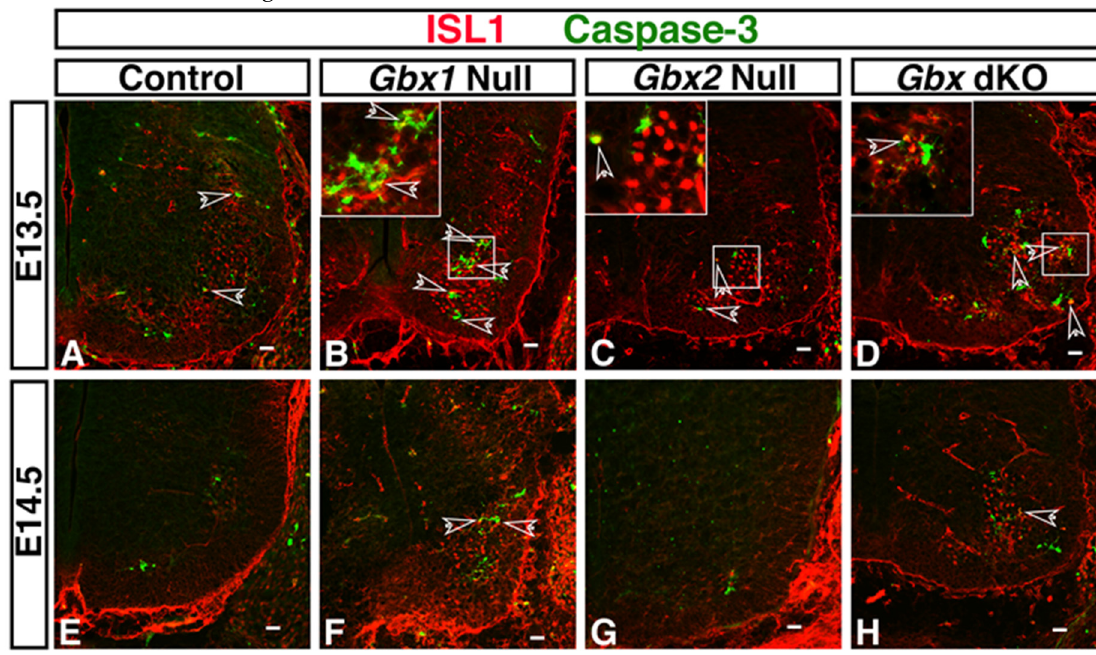
Figure 5. Caspase-3 colocalizes with Islet1 + motor neurons in the ventral spinal cord of Gbx mutants. Immunostaining to detect caspase-3 + apoptotic spinal neurons in the lumbar spinal cords of Gbx1 − / − , Gbx2 − / − , and Gbx dKO mutants at E13.5 ( A – D ) and E14.5 ( E – H ). Co-immunostaining with ISL1 antibody allows for the analysis of apoptotic neurons co-expressing the marker of spinal motor neurons. Upon analysis at E13.5, control embryos express a few cells immunopositive for caspase-3, however, none of these cells colocalize with cell bodies expressing ISl1, indicating that under normal condition at this stage, motor neurons do not undergo apoptosis. In the Gbx mutants however, some cells immunopositive for caspase-3 colocalize with ISL1 + motor neurons in the ventral spinal cord (white arrows and insets in B – D ). This indicates a role for Gbx in survival of a subset of ISL1 populations as early as E13.5. At E14.5, apoptotic cells are detectable in the ventral spinal cord of control embryos. This level of caspase-3 immunoreactivity is persistent in Gbx1 − / − and Gbx dKO embryos, where a subset of apoptotic cells colocalize with ISL1 + motor neurons ( F and H , white arrowhead). Notably, few to no cells are caspase-3 + in Gbx2 − / − mutant embryos. Scale bars represent 50 µ m. N = 3 for each genotype, at each stage. Insets are 40 × magnification of boxed regions in ( B – D ).